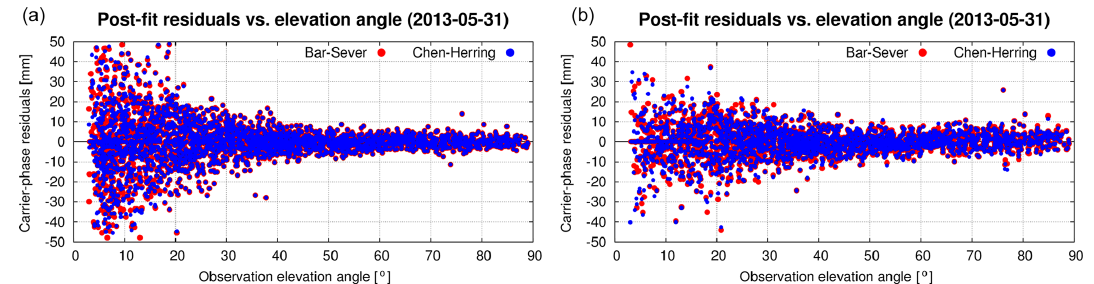
Figure 5. Post-fit-phase residuals’ distribution when using different gradient mapping functions, Bar-Sever (red) and Chen and Herring (blue), and observation weighting: SINEL2 (a) and EQUAL (b)